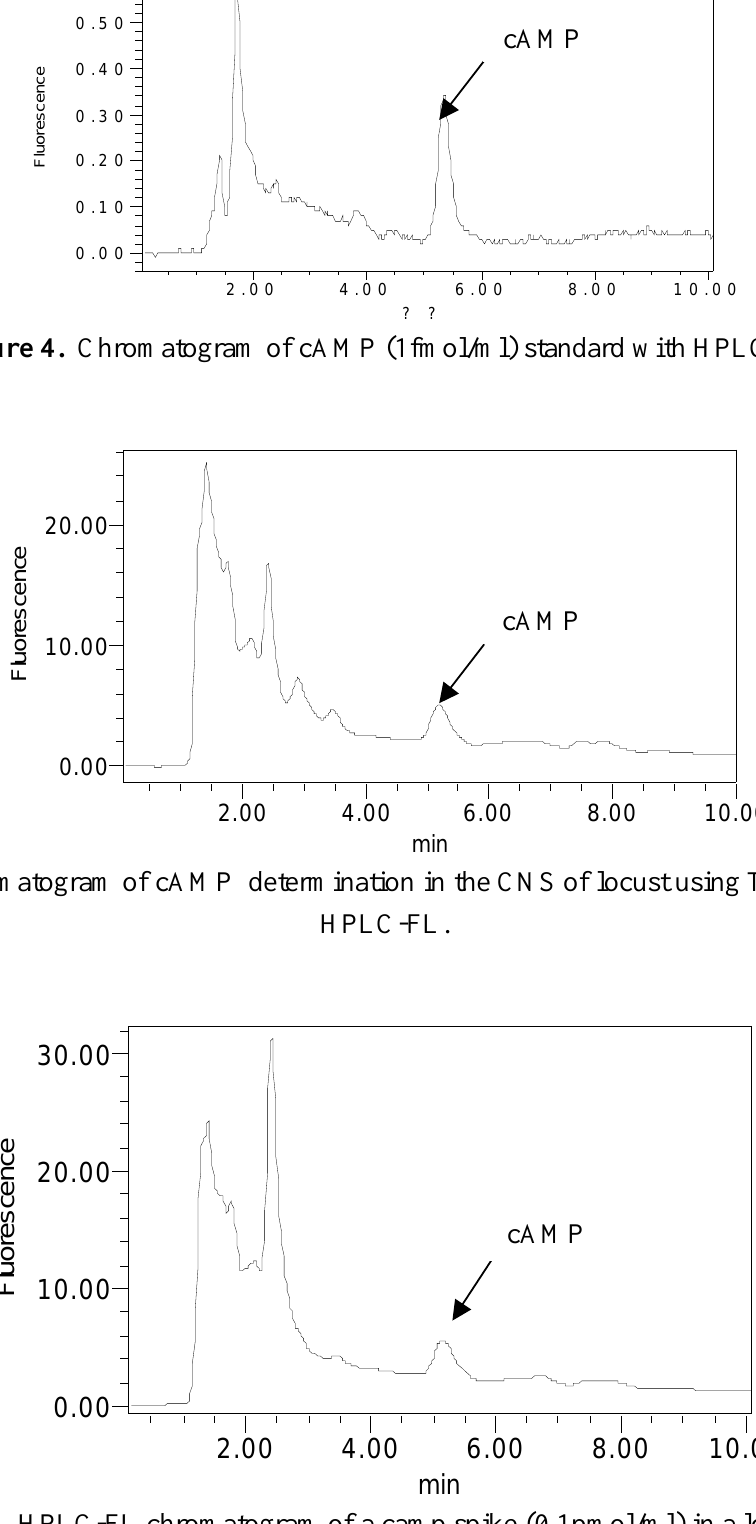
Figure 6. HPLC-FL chromatogram of a camp spike (0.1pmol/ml) in a locust CNS.